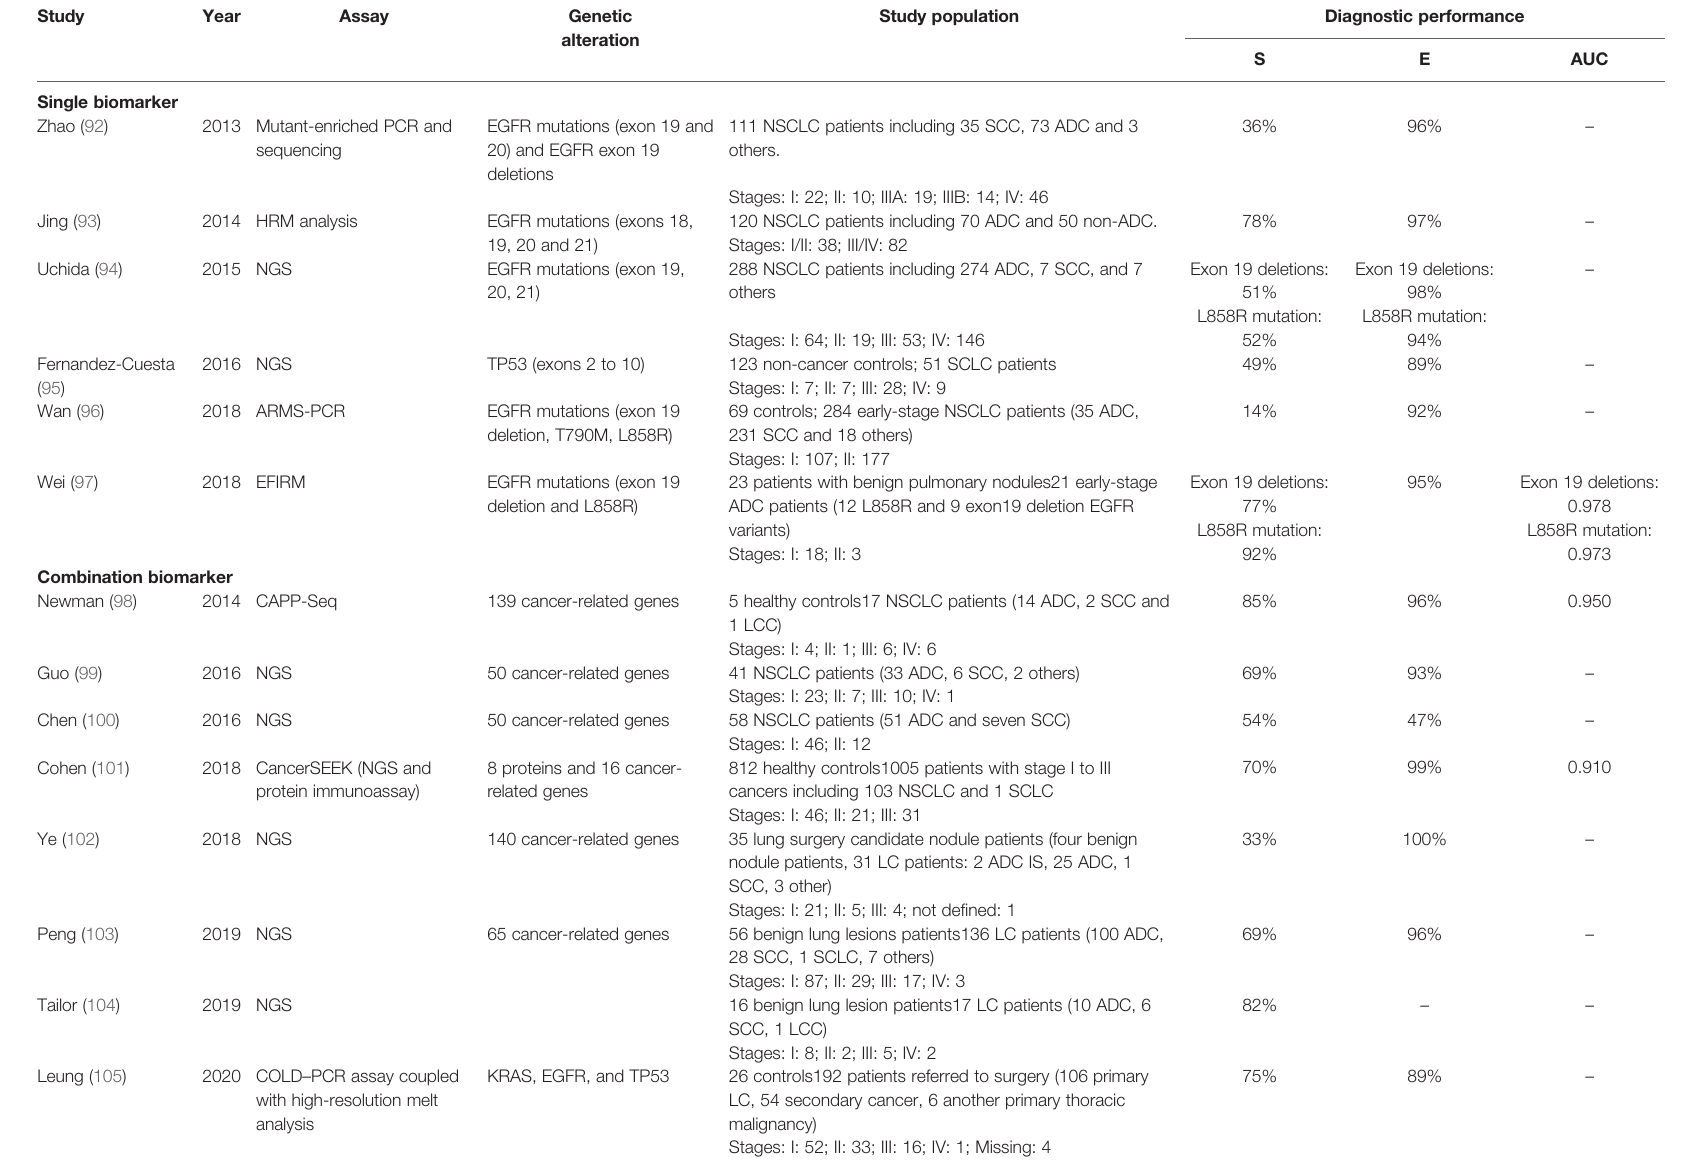
TABLE 3 | Plasma cfDNA genetic alterations performance as biomarker for lung cancer